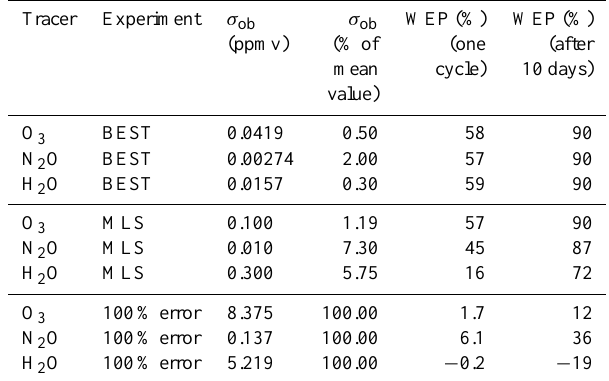
Fig. 9. WEP (in %) as a function of time for BEST, MLS, 100% er- ror and “no data” experiments: O 3 (red), N 2 O (green), H 2 O (blue), and “no data” (black). The “no data” indicates the WEP diagnos- tic applied to a 10-day forecast with no data assimilated. Circles indicate the initial WEP values (0% in each